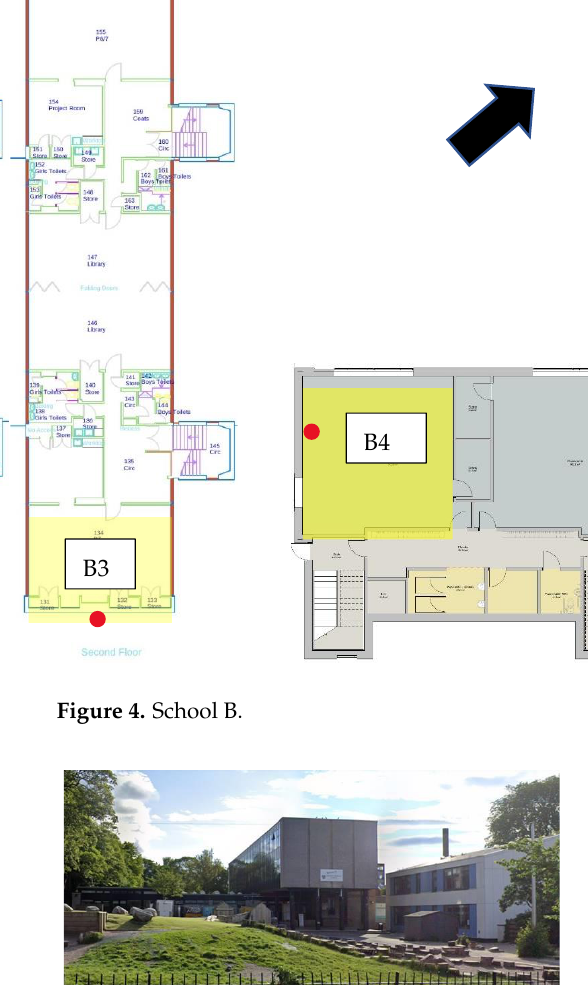
Figure 5. Picture of school B.